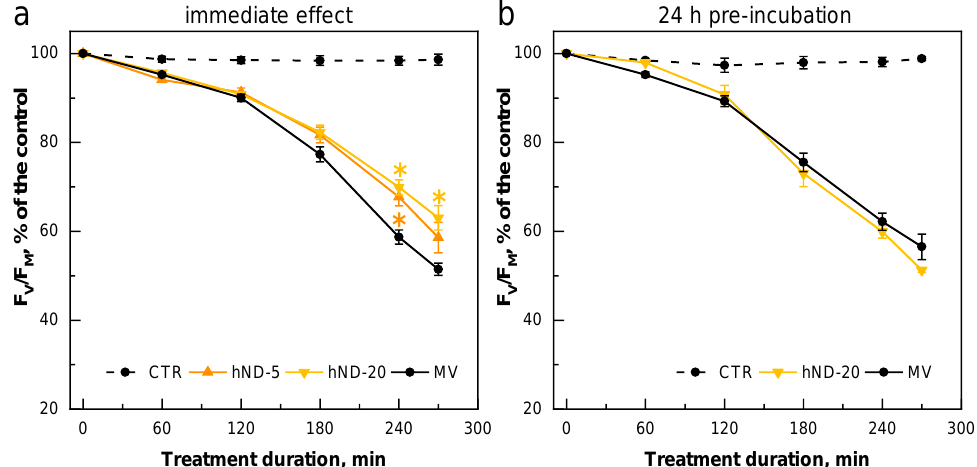
Figure 4. Changes in the F V /F M parameter induced by 3 μM MV in C. reinhardtii cultures supplemented with a low concentration of hNDs (5 and 20 μg/mL). ( a ) “immediate effect”—MV and hNDs were added simultaneously to the cultures. ( b ) “24 h pre-incubation effect”—MV was added to cultures pre-incubated for 24 h with hNDs. Values are expressed as a % of the control, F V /F M (T0) = 0.73 ± 0.005 ( a ) and F V /F M (T0) = 0.74 ± 0.006 ( b ). Asterisks indicate statistically significant differences between the MV and hND samples at corresponding time points, p < 0.05. Means of 2–4 independent experiments with 2–3 biological replicates ( ± SE, n =